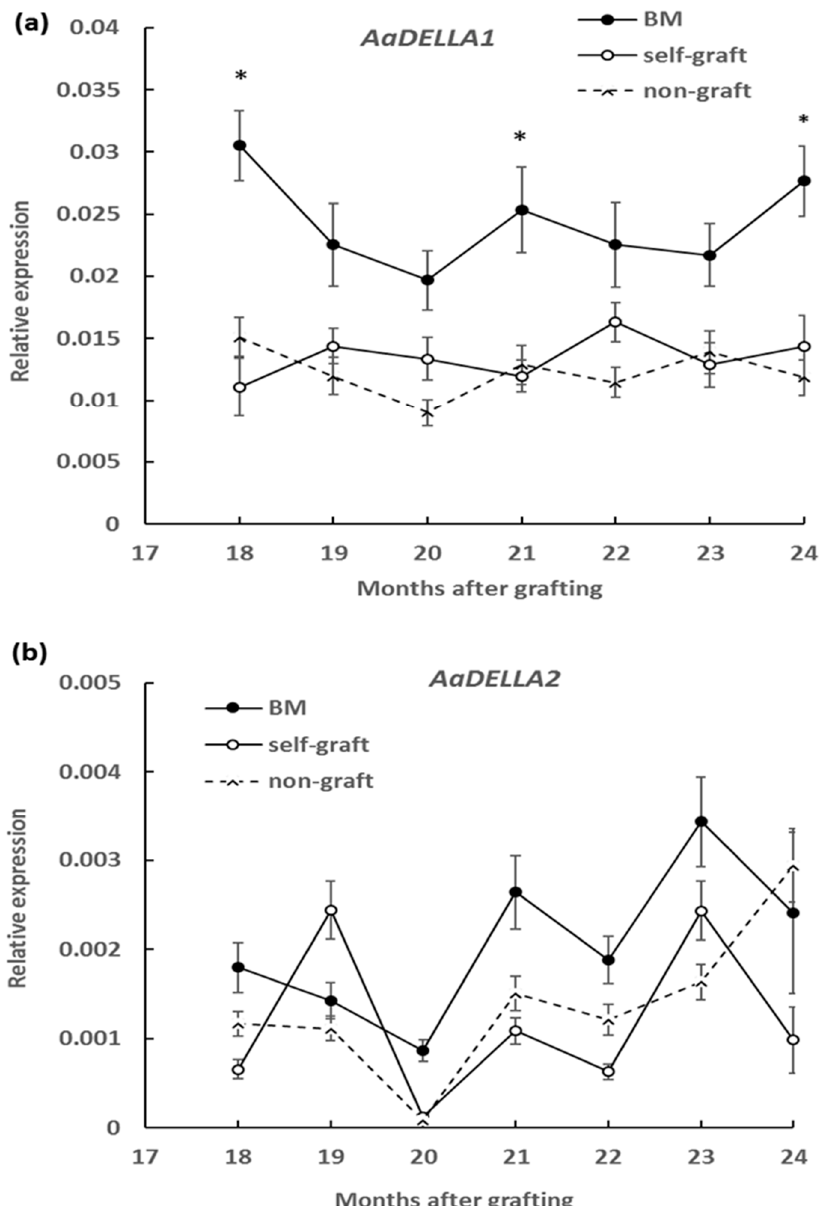
Figure 4. Effect of rootstocks on the expression of DELLA genes, AaDELLA1 and AaDELLA2 , in breadfruit scion stems: Expression level of each transcript was normalized to the expression level of the actin gene. BM, breadfruit plants growing on marang rootstocks. All values represent mean ± SE from five separate RNA extractions (* p < 0.05). ( a ) AaDELLA1 ; ( b ) AaDELLA2.